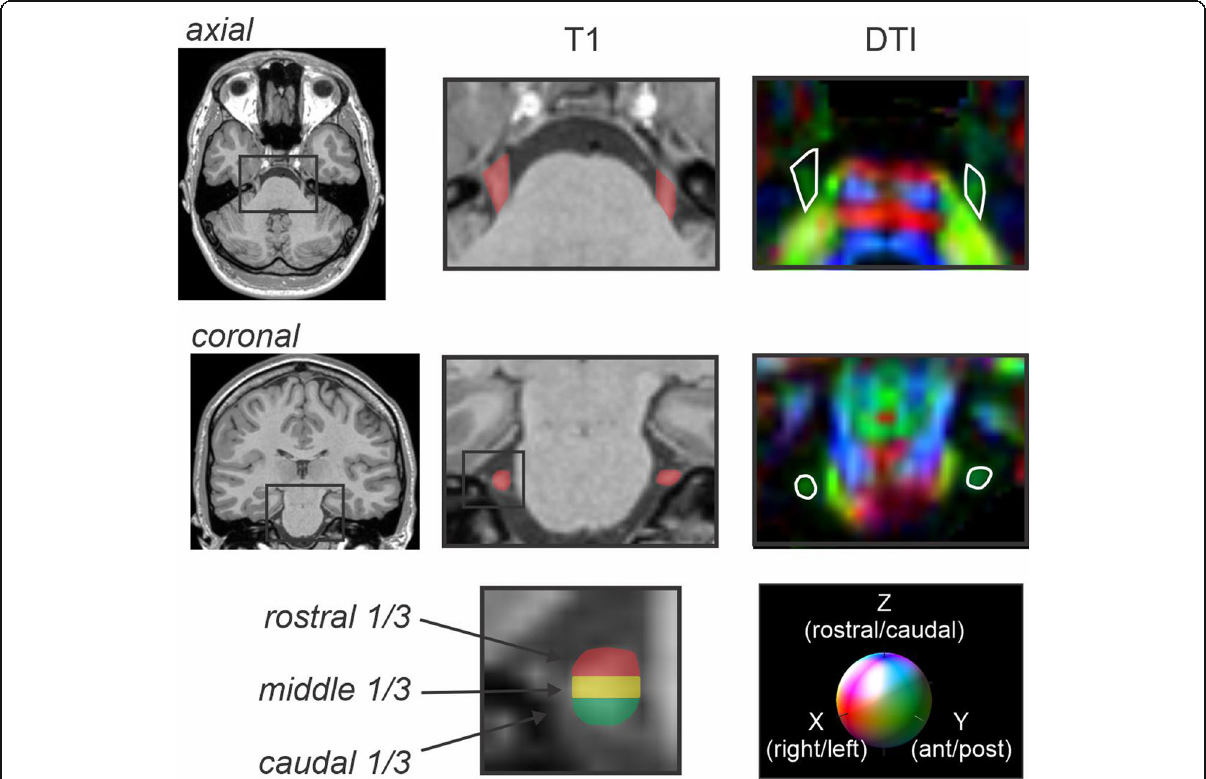
Fig. 1 Axial and coronal T1-weighted anatomical images and corresponding diffusion tensor (DTI) images showing the trigeminal nerve root entry zone in a single subject. The DTI image is color-coded for direction of greatest water movement. The outline of the trigeminal nerve region used for total nerve analysis is also shown in red shading on the T1-weighted anatomical image and outlined in white on DTI images. To the right is an example of the regions selected for the rostral (red), middle (yellow) and caudal (green) third of the nerve at the maximal cross-sectional